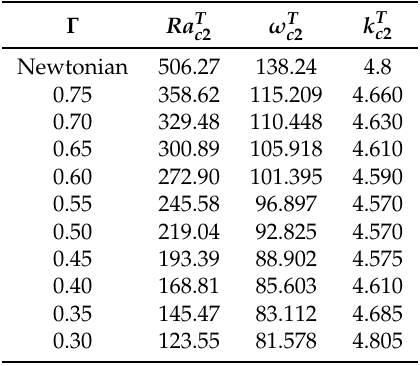
, frequency ω T and wave number k T at the onset of moving c 2 c 2 c 2